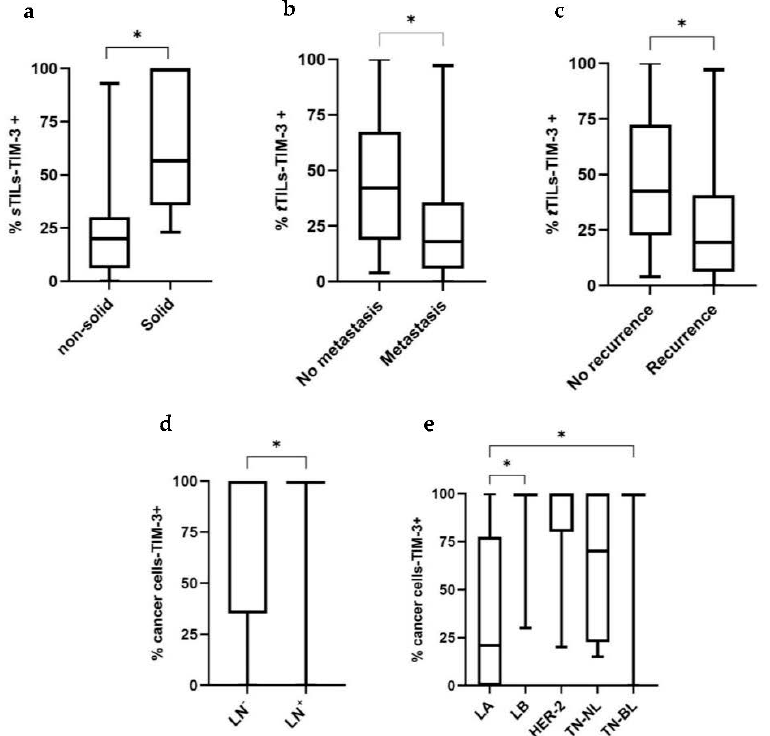
Figure 3. Box plot analysis of stromal and total TILs-TIM-3+ and cancer cells-TIM-3+ and their association with clinicopathological features. ( a ) The percentage of sTILs-TIM-3+ is associated with the solid histological subtype (non-solid, n = 39; solid, n = 6). ( b ) The percentage of tTILs-TIM-3+ is associated with lower tumor metastasis (no metastasis, n = 18; metastasis, n = 27) and ( c ) tumor recurrence (no recurrence, n = 14; recurrence, n = 29). ( d ) The percentage of cancer cells-TIM-3+ is associated with a positive lymph node status (LN) (negative LN status, n = 26; positive LN status, n = 16) and ( e ) is higher in the LB and TN-BL carcinomas, compared with LA carcinomas (LA, n = 6; LB, n = 17; HER-2, n = 9; TN-NL, n = 5; TN-BL, n = 8) (* p < 0.05).